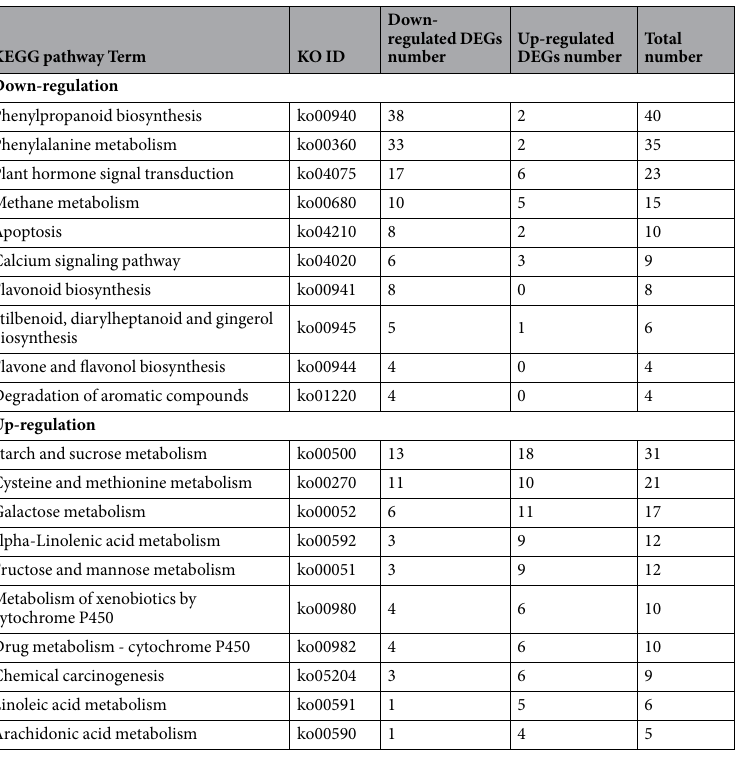
KEGG pathway Term KO